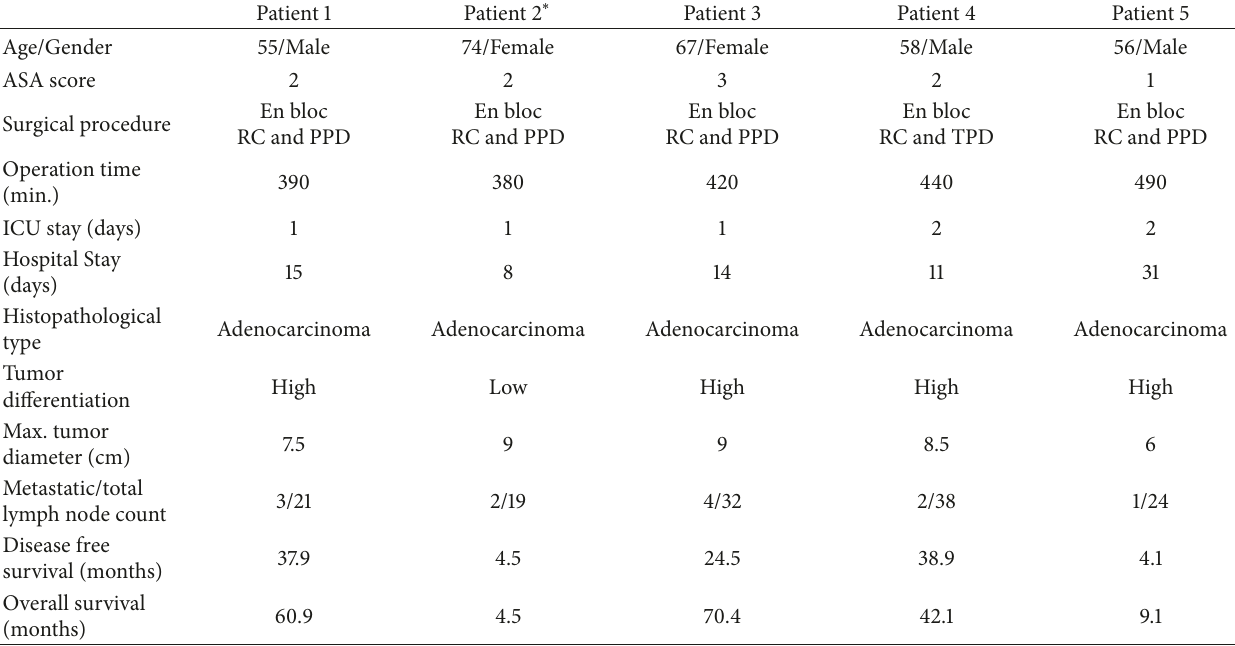
Table 1: Patient demographics, perioperative data, histopathological features and oncological follow up